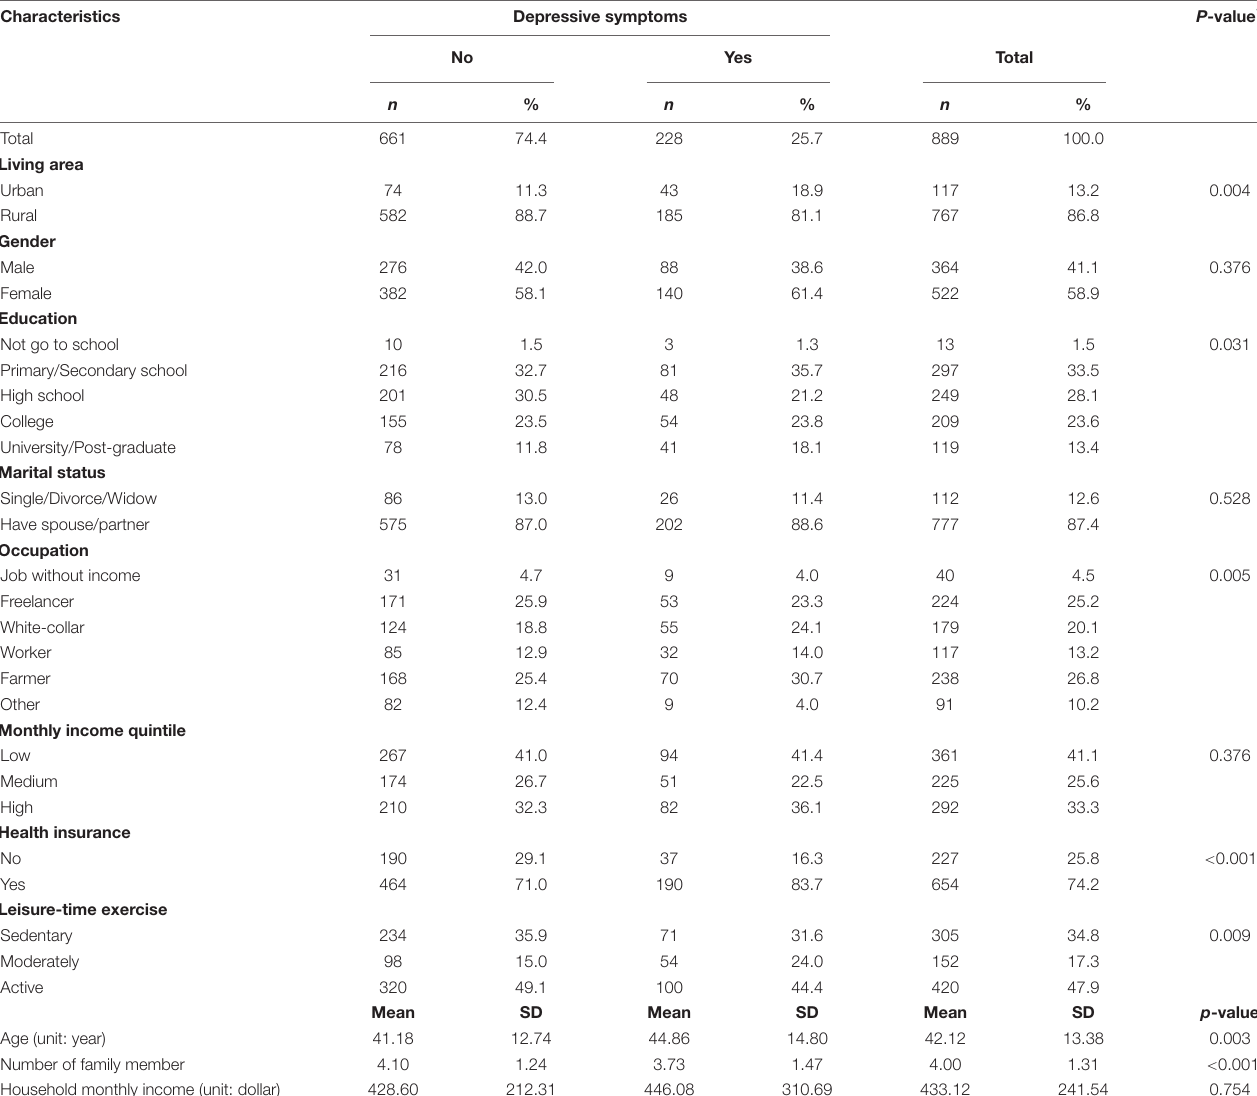
TABLE 1 | Sociodemographic characteristics of